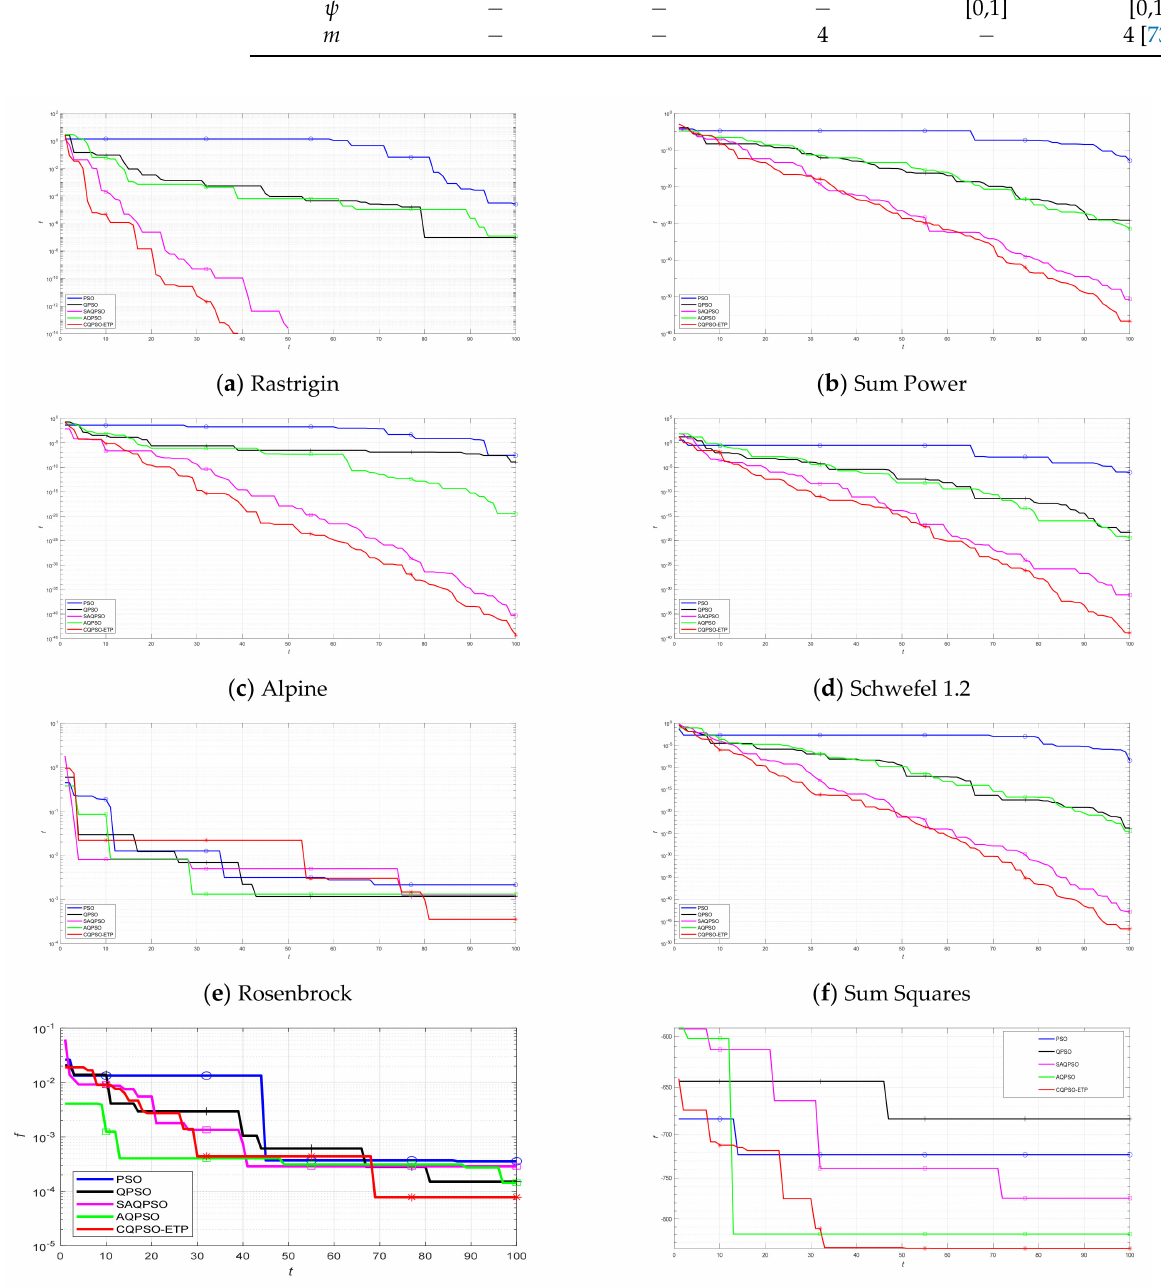
Figure 5. Convergence of the comparative approaches on eight numerical benchmark functions ( D =